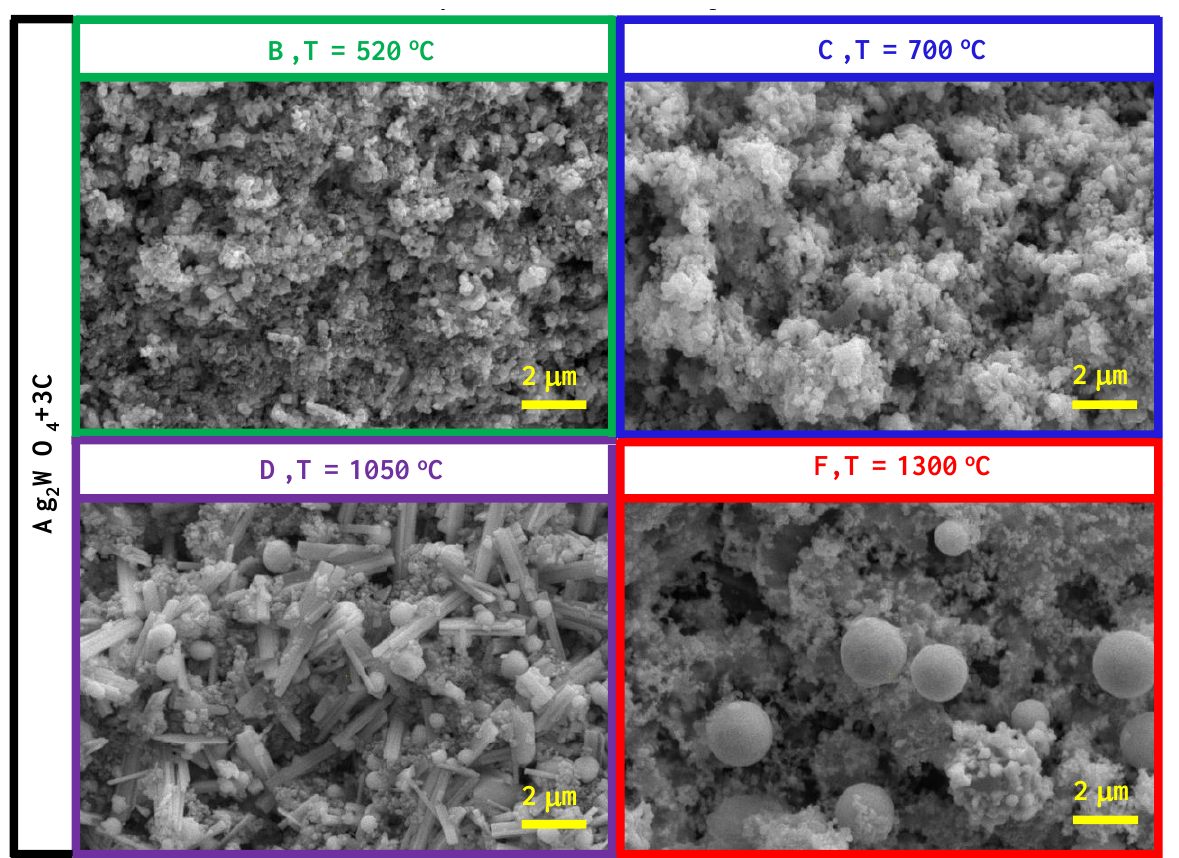
Figure 6. SEM images of quenched samples for the Ag 2 WO 4 + 3C mixture.